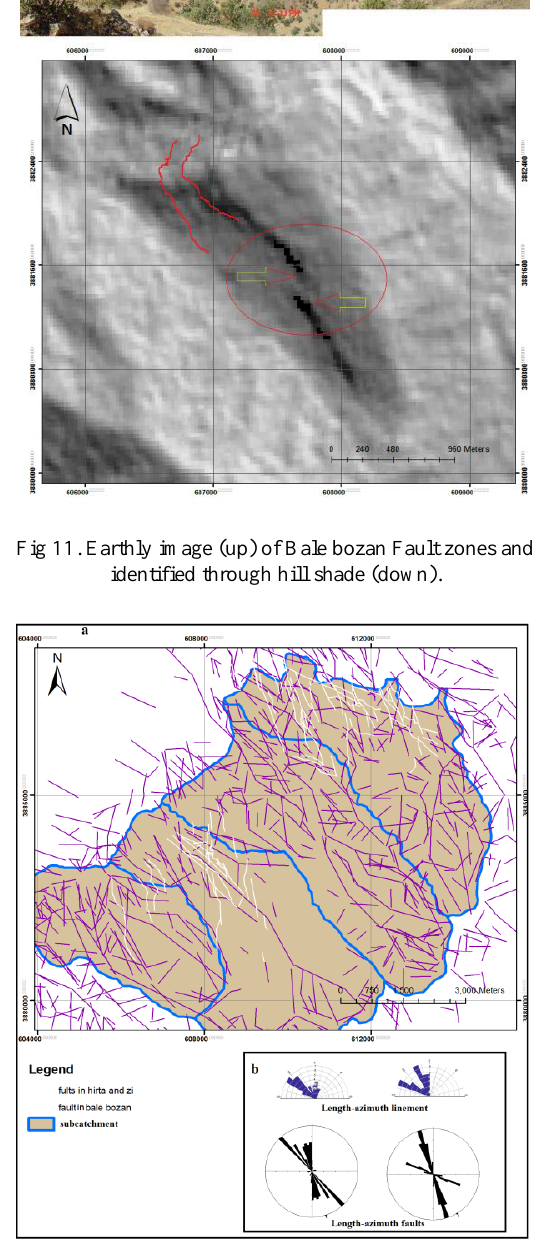
Fig 12. Integrated mapping lineaments and faults in the study